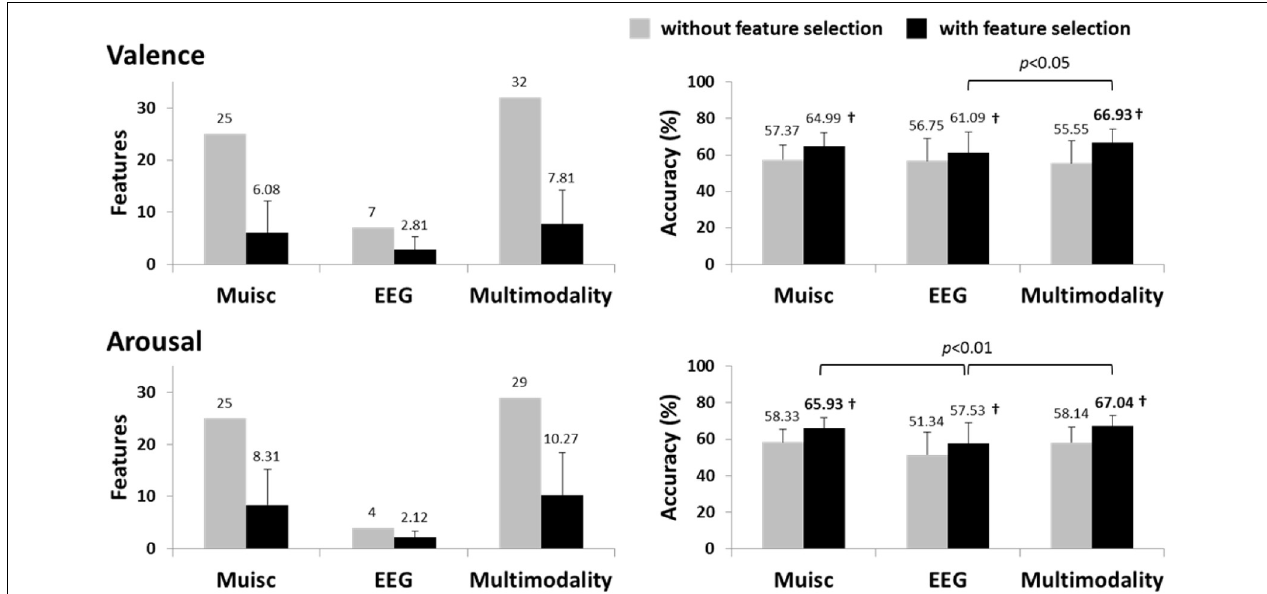
FIGURE 7 | The valence and arousal classification results using the subject-independent multimodal approach (LFI = 0.6) with/without feature selection. The results of the subject-independent EEG modality (feature type: MESH) and the music modality (feature type: MUSIC) are also provided for comparison. The numbers above the bars represent the